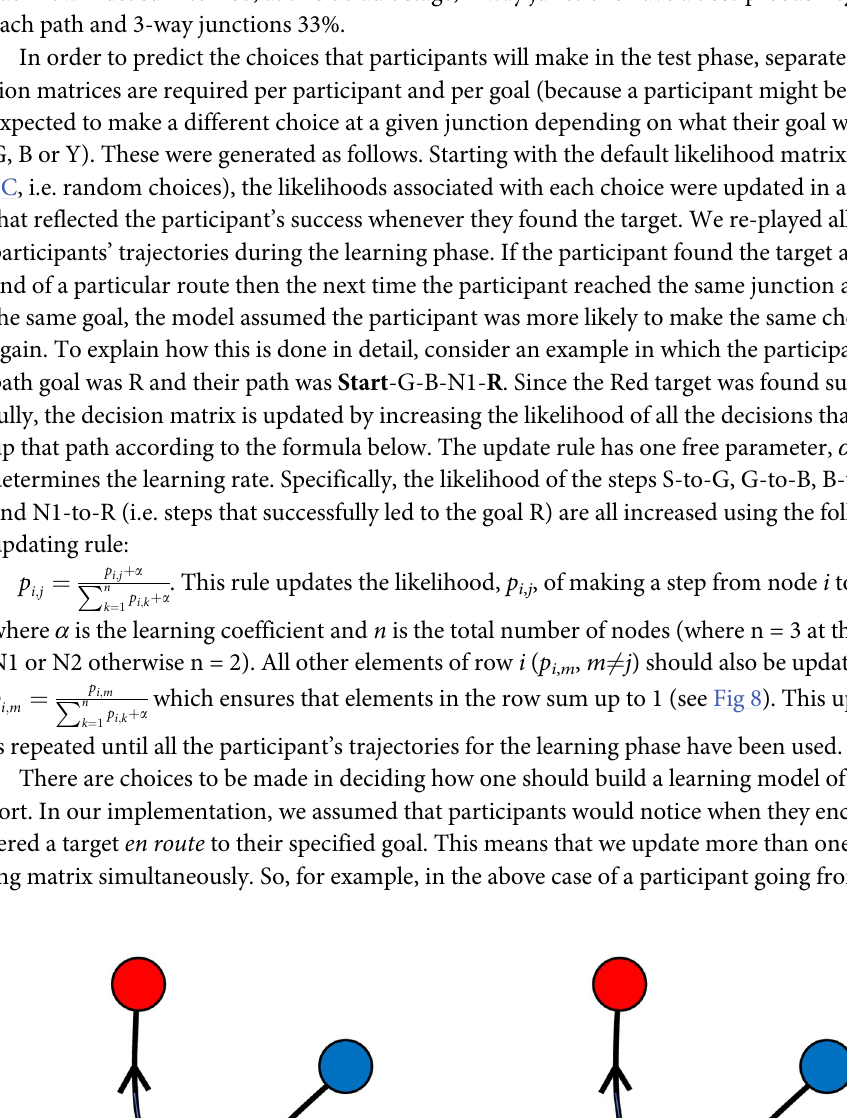
¼ p i ; j þ a P n (see i ; j k ¼ 1 p i ; k þ a ¼ p i ; m P n (see text). This gives the i ; m þ a k ¼ 1 p i ; k